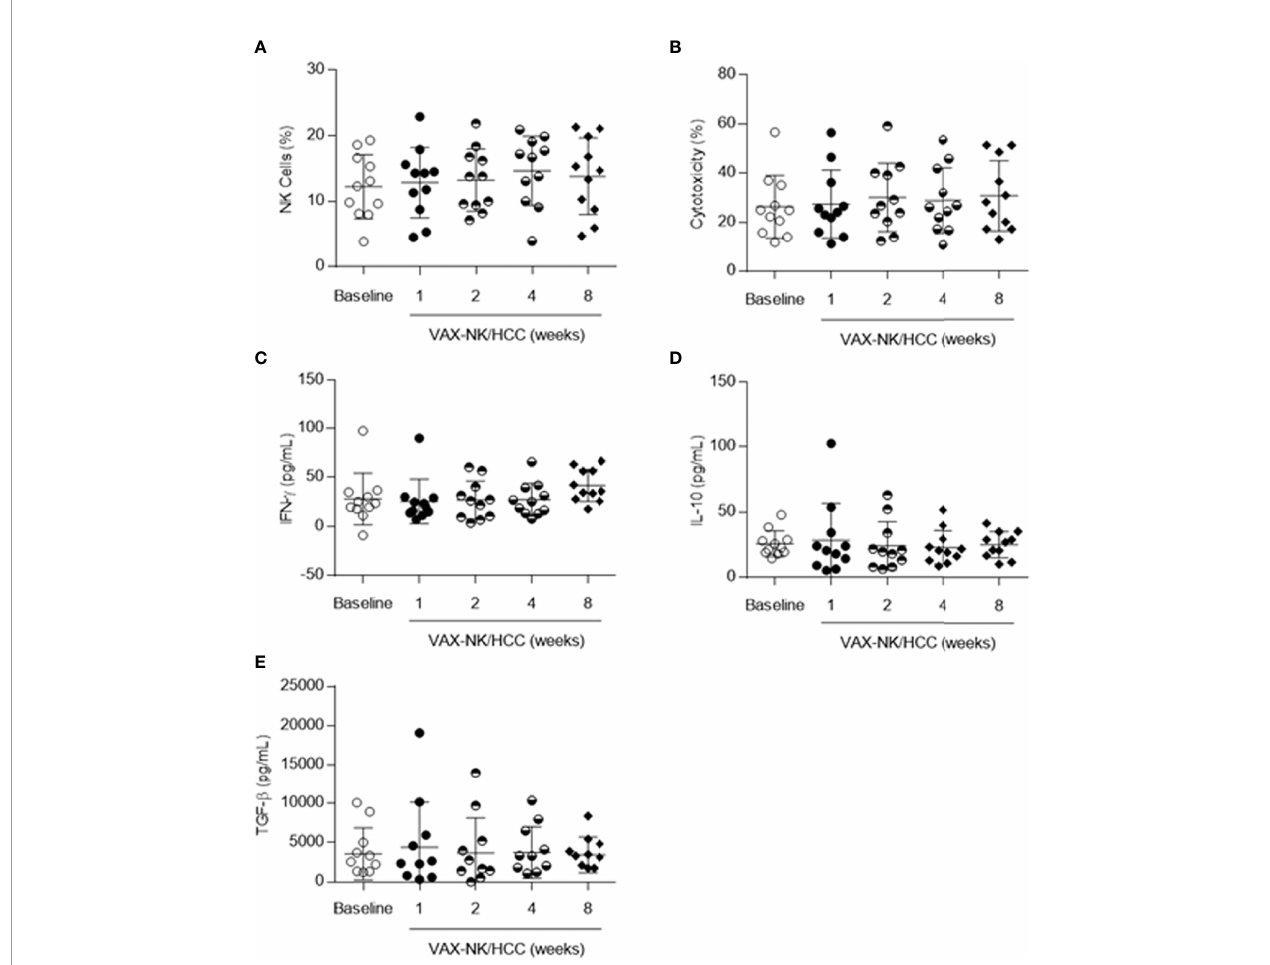
FIGURE 5 | Immunopro fi ling during and after treatment. (A) Percentages of peripheral NK cells with CD3 - CD56 + before and after locoregional NK cell infusion. (B) The cytotoxic activity of PBMCs against K-562 cells at effector to a 10:1 E:T ratio. (C – E) The serum cytokine levels of IFN- g , IL-10, and TGF- b